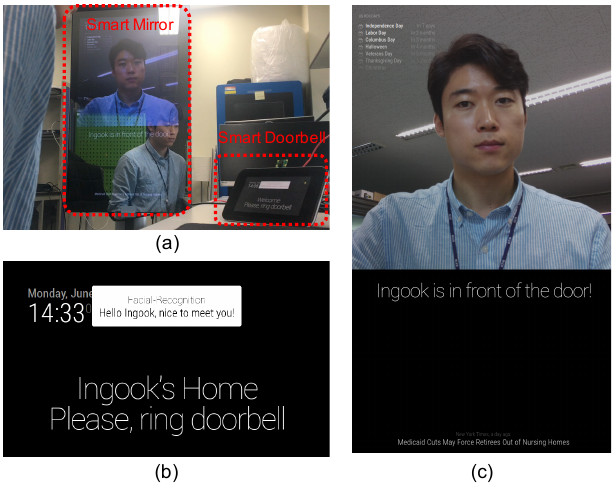
Figure 7. Prototype of our smart home system with a smart mirror and a smart doorbell; ( a ) the smart doorbell notifies someone’s visit to in-house members through the smart mirror, and ( b ) the screen of the smart doorbell and ( c ) that of the smart mirror after face recognition are shown. (Adapted from [8] with permission of